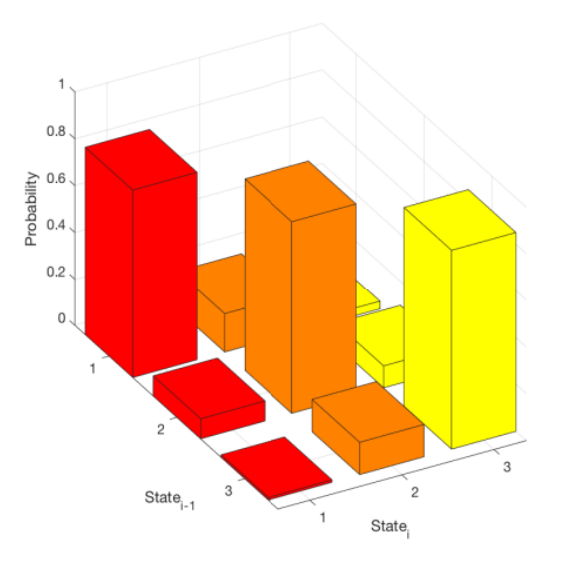
Figure 5. Graphical representation of cloud coverage transition probability